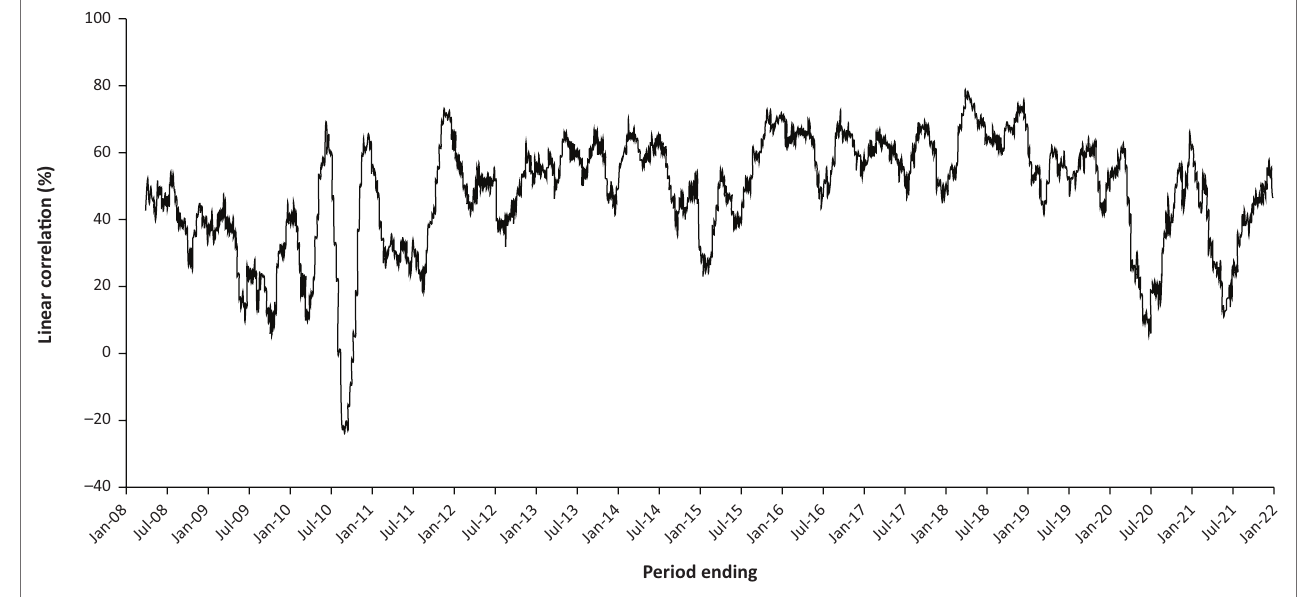
FIGURE 11: Pearson linear correlation between SABOND10 and ZAR over rolling 3-month periods from 2008 to 2022.